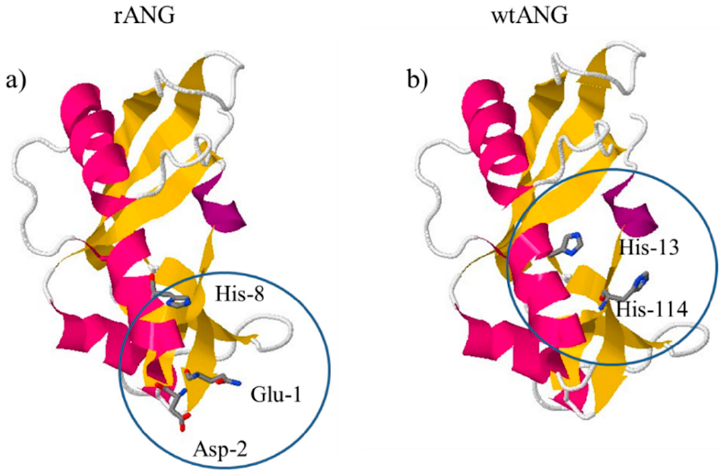
Figure 6. Putative anchor site of Cu 2+ in ( a ) rANG and ( b ) wtANG copper complexes (PDB ID 1ANG).